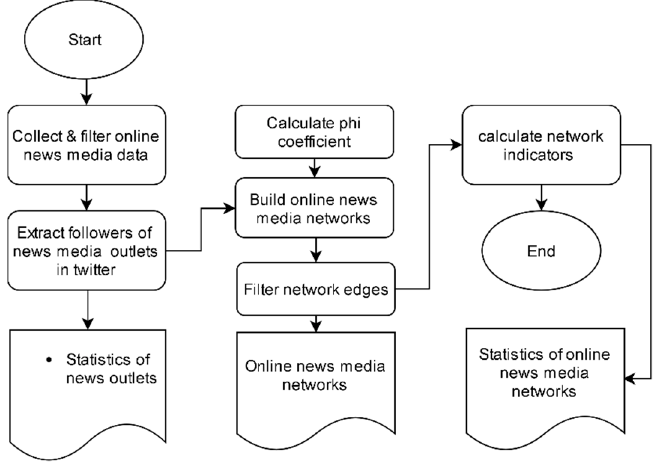
Figure 1. Research methodology